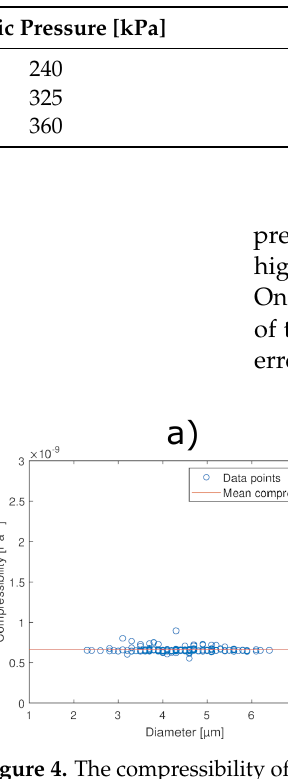
Table 2. The experimentally determined compressibilities of the Pickering-stabilized droplets at three different acoustic pressures and the theoretically estimated and experimentally determined acoustic contrast factor Φ using Equations (2a,b) and (3).